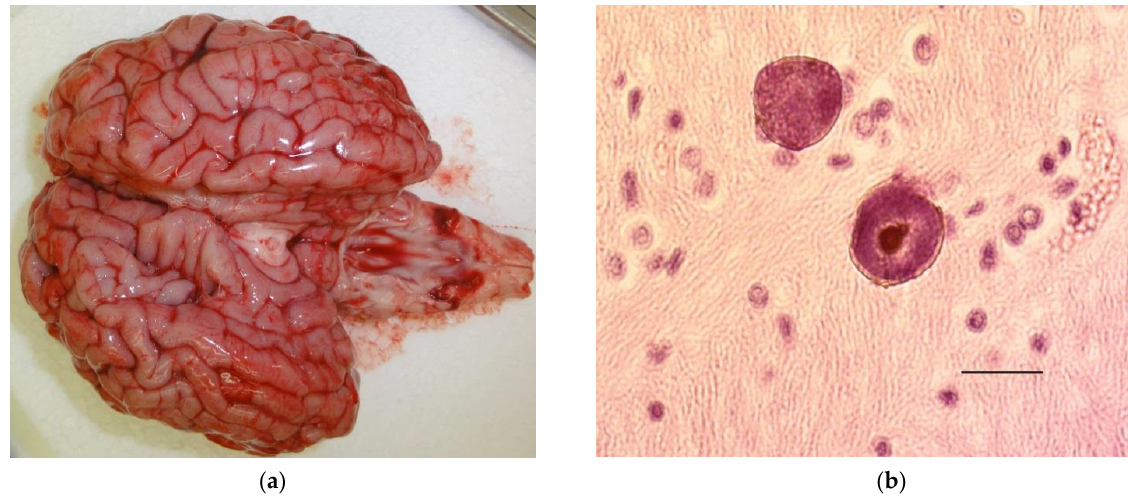
Figure 2. ( a ) ( left ) Grossly normal brain from a calf that died in the perinatal period with Neospora caninum cysts in its brain. ( b ) ( right ) Neospora caninum cysts in the brain of a calf that died in the perinatal period. Bar 20 µm.